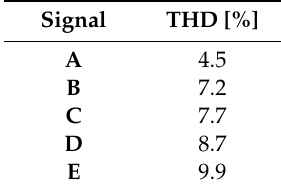
Table 2. List of the acquired signals and their total harmonic distortion (THD).